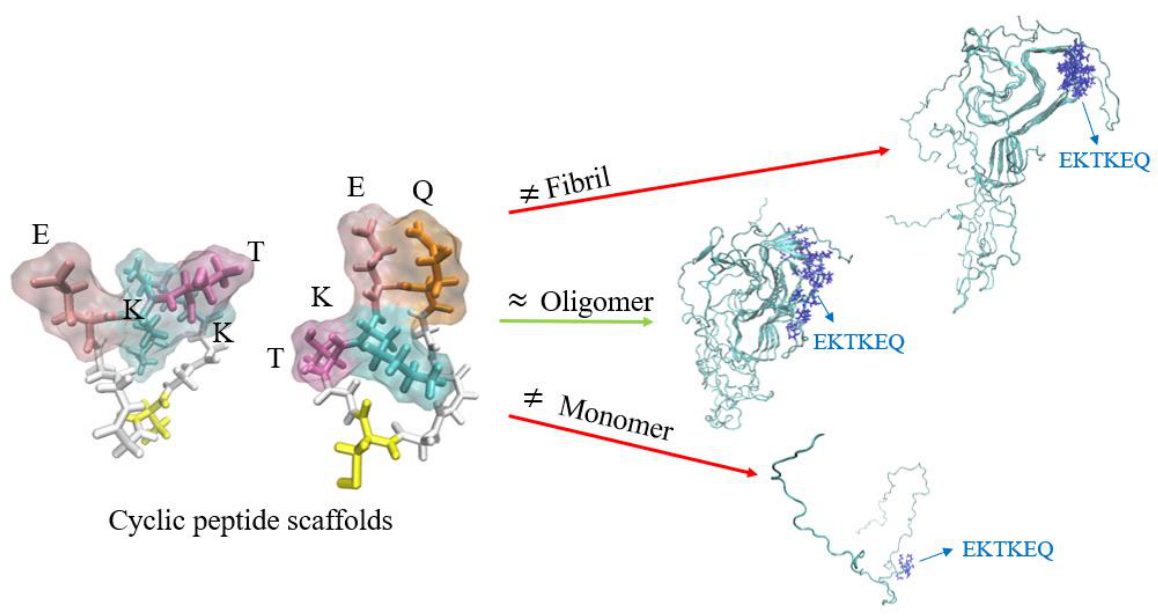
Figure 1. Alpha-synuclein residues 57-60 (EKTK) and 59-62 (TKEQ), held in a constrained turn, represent conformational epitopes predicted to be exposed on oligomers and small soluble fibrils but not monomers or fully formed insoluble fibrils. Representative molecular dynamics simulated conformations of the cyclic epitopes with the side chains oriented into solvent are shown. To assess the biological relevance of the predicted epitopes, a representative peptide scaffold, cyclo (CGTKEQGGGG), was tested for its ability to replicate the seeding activity and neurotoxicity of small soluble fibrils and α -Syn oligomers, respectively (Figure 2). Seeding activity was tested in a Thioflavin-T (ThT) fluorescence assay, which measures the fibrillogenic aggregation of α -Syn protein monomers over time in the absence or pres- ence of peptide. While monomers incubated alone did not undergo detectable aggregation under the conditions tested, the presence of the cyclic peptide scaffold promoted aggre- gation, as shown by a steady increase in fluorescence signal after an initial lag period, reaching a plateau approximately 120 h later. In contrast, the corresponding linear peptide did not exhibit any seeding activity (Figure 2a). In addition, negative stain electron mi- croscopy analysis of the material recovered in the plateau phase at the end of the incuba- tion period indicated that the morphology of fibrils seeded by peptide scaffolds resembles that of fibrils seeded with sonicated PFFs (Figure S3). Notably, the average widths of fi- brils seeded by peptide scaffolds (12.2 ± 1.5 nm for cyclo (CGGKTKEGG) and 11.3 ± 1.6 nm for cyclo (CGGEKTKGGG) are consistent with those of fibrils seeded by PFFs (11.5 ± 1.6 nm). In cultures of rat primary dopaminergic neurons, the conformational cyclic peptide scaffold by itself exhibited toxicity comparable to that of α -Syn oligomers. In contrast, the corresponding linear version of the same peptide was devoid of toxicity and did not affect neuronal viability (Figure 2b).